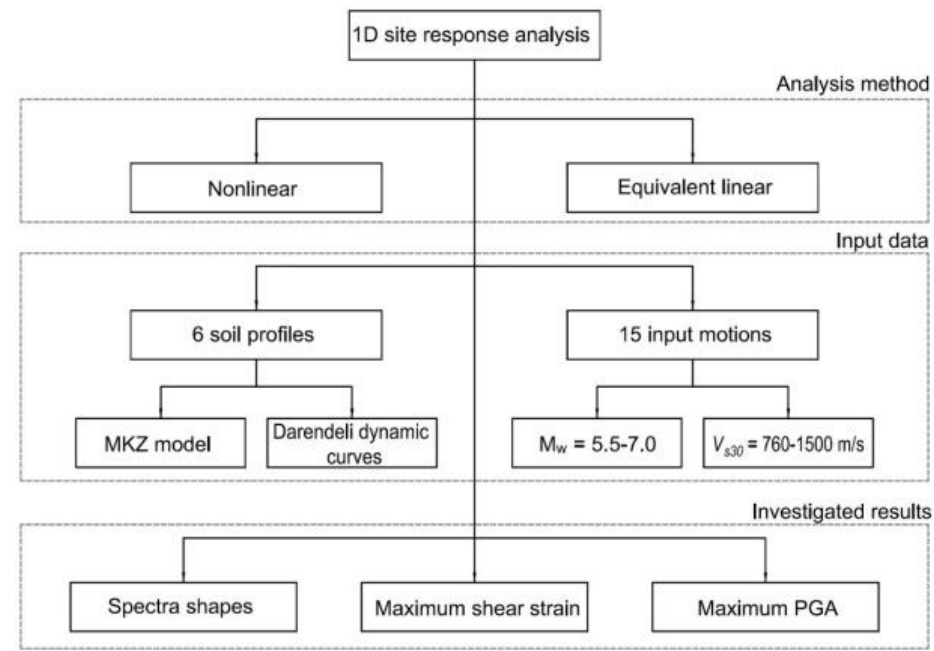
Figure 4. Site response analysis procedure in this study.